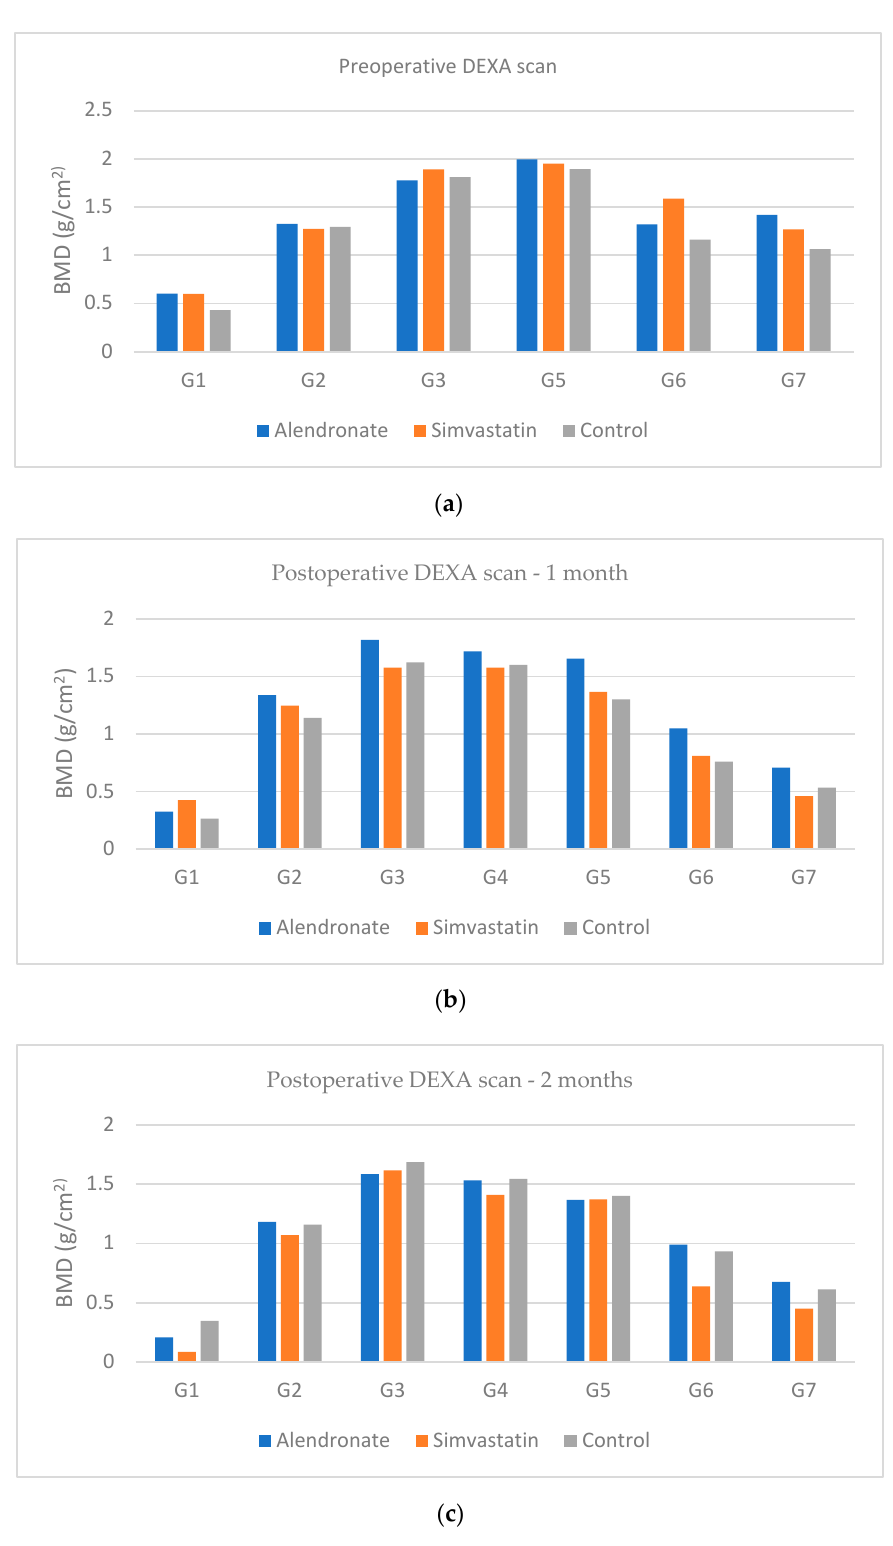
Figure 3. Preoperative DEXA scan ( a ); postoperative DEXA scan at one month ( b ); postoperative DEXA scan at two months ( c ).